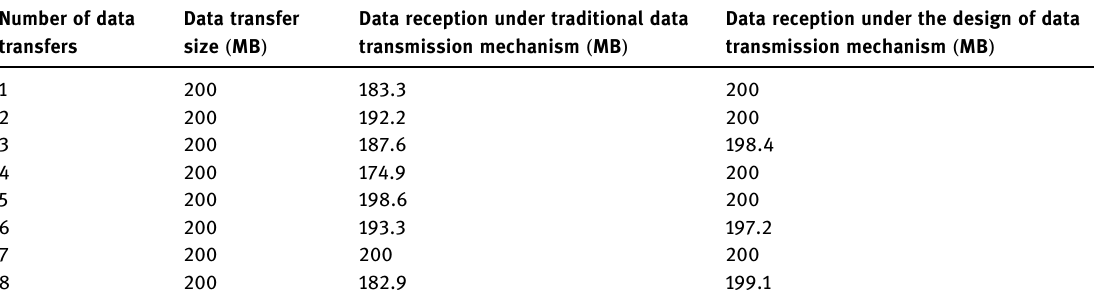
Table 1: Experimental results of packet loss